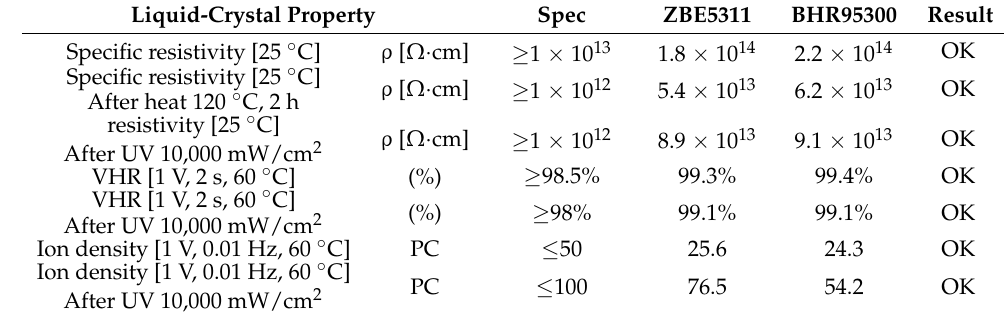
Table 7. Quality